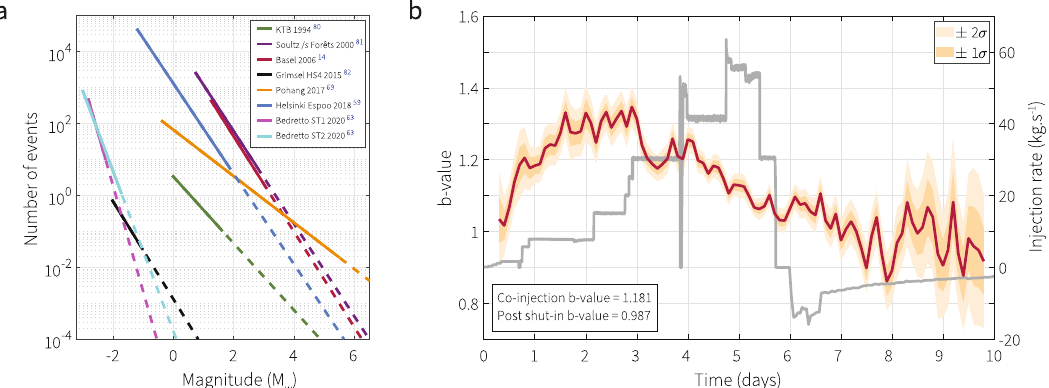
Fig. 1 The b -value varies from site to site, and in time. a Frequency-Magnitude Distribution of selected EGS and scienti fi c injection activities. The thick line stops at the maximum observed magnitude, while the dashed line shows the extrapolation to higher magnitudes 14,59,63,69,80 – 82 . All magnitudes are converted to M w , see Supplementary Table S1 for details. b Temporal evolution of the b -value with a high-resolution catalogue in Basel during the December 2006 geothermal stimulation. Time zero corresponds to the start of the full injection phase on 2 December 2006 at 18:00. The events are binned in 0.2 days windows with a 0.1 days overlap. The shaded area show the ± one and two standard deviation of the calculated b -value.